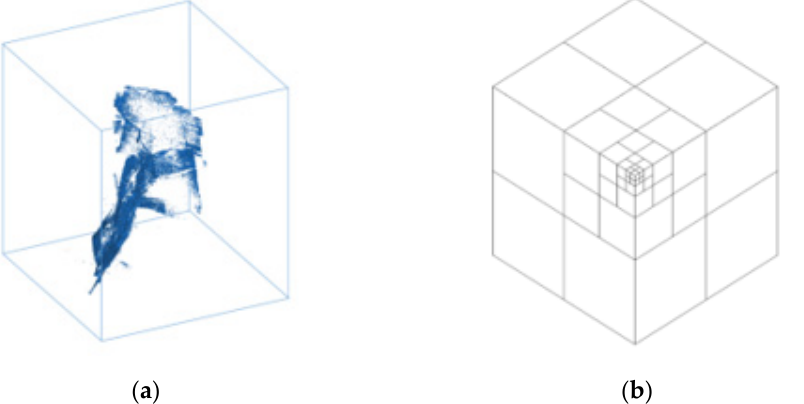
Figure 4. Digital image of a fracture ( a ) and schematic of the cubic covering method to calculate the fractal dimension ( b ).